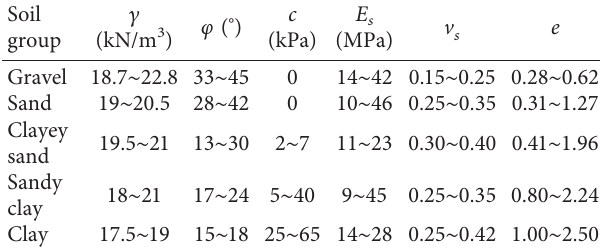
Table 4: The general geotechnical parameters. c Soil group (kN/m 3 )